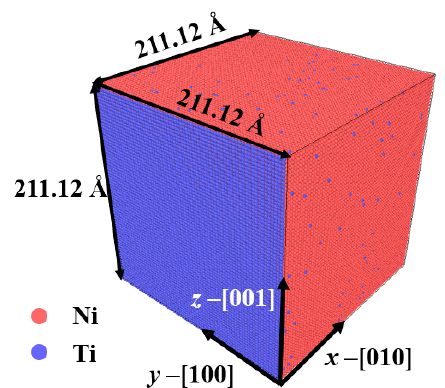
Figure 4. Atomic configuration of a single crystalline NiTi box with 50.5% Ti content.